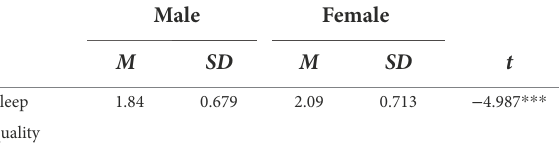
TABLE 5 T -test of sleep quality among male and female college students.